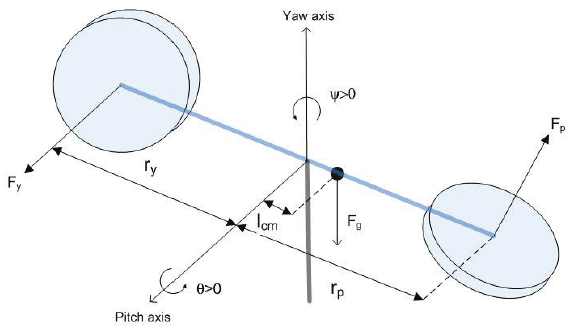
Figure 2. Schematic of the 2-degree of freedom (DOF)